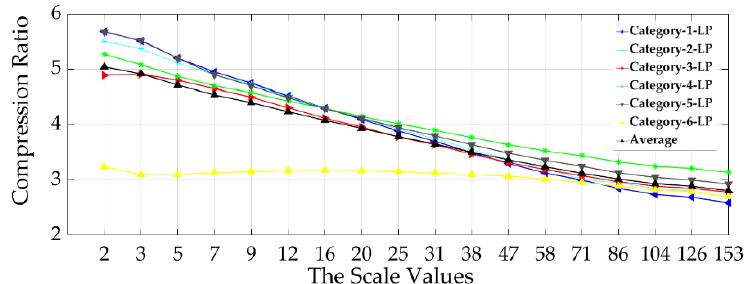
Figure 15 . Relationship between the scale of analysis and the six surface categories compression performance by using the multiscale low-pass (LP) data sets.